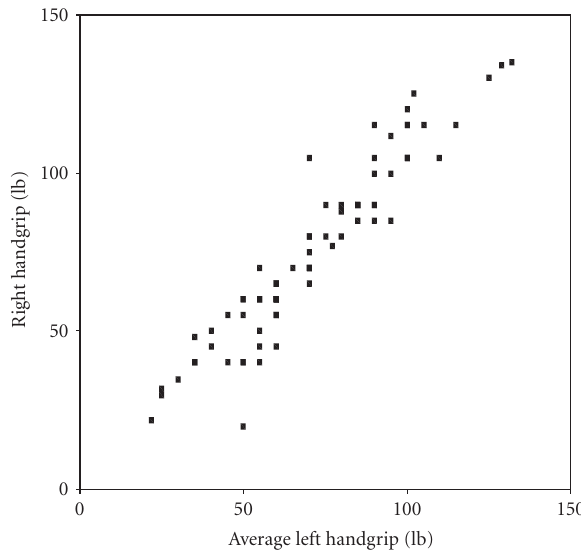
Figure 2: Scatter graph showing the correlation between right and left